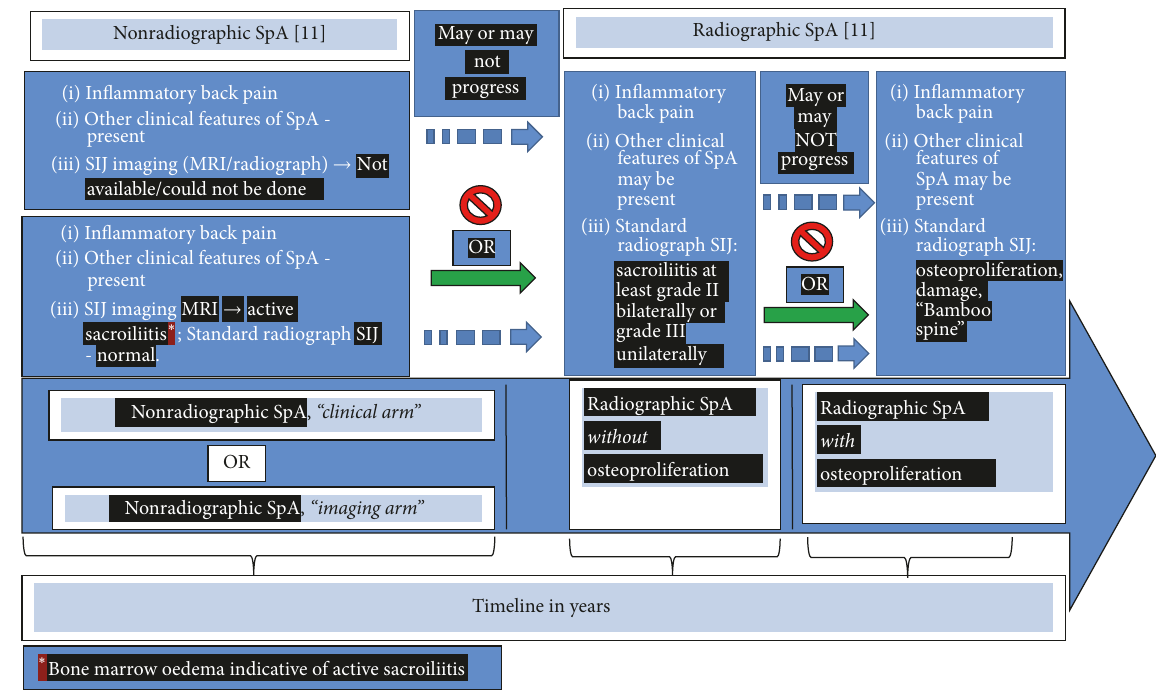
Figure 2: Natural history of axial SpA over timeline → from left to right. For details see